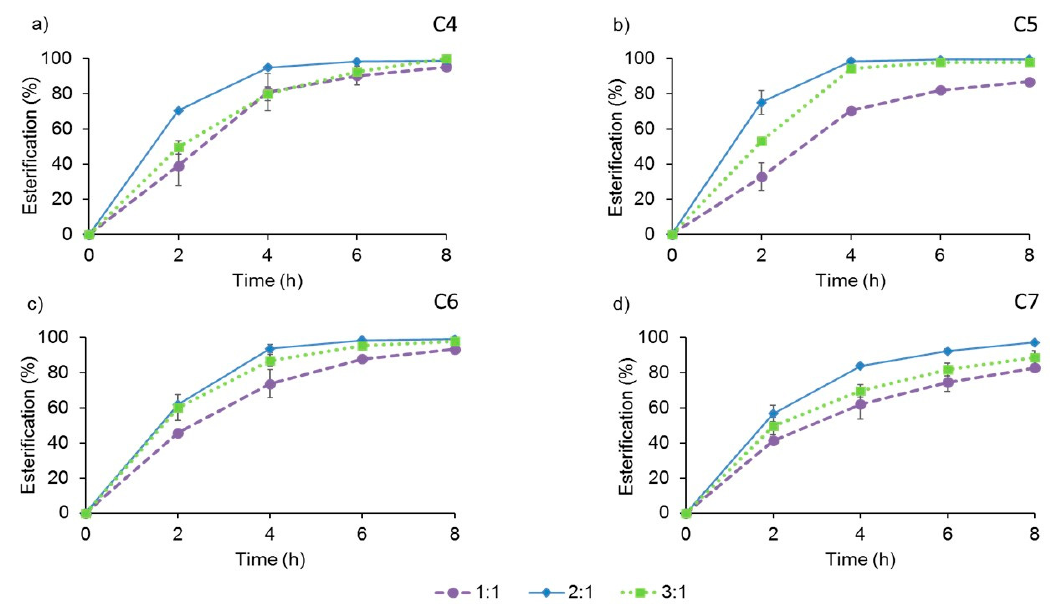
Figure 3. Effect of the molar ratio of 1-butanol and each VFA on the time-course of the esterification catalyzed by AMNP-GA-OPEr: ( a ) butanoic (C4); ( b ) pentanoic (C5); ( c ) hexanoic (C6); and ( d ) heptanoic (C7) acid. Reactions were performed in isooctane, at 100 rpm and 25 °C, with 11 U of catalyst and 100 mM of each VFA.